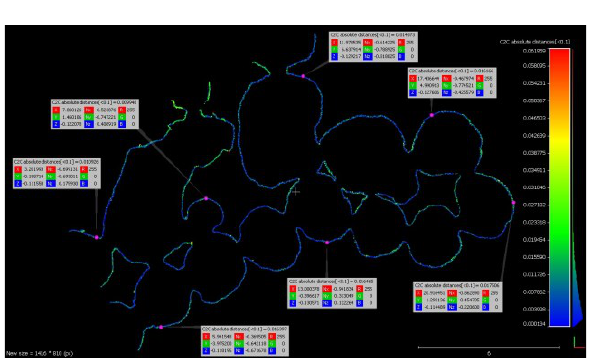
Figure 8 . Rooms 10 -18 to 27: C2C analyses of horizontal slices between the P30 and BLK2GO point clouds (calculation range: 0.00-0.02 m).